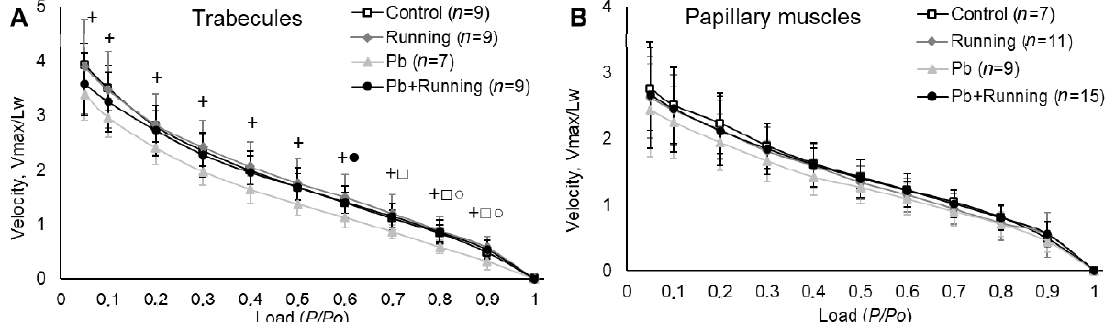
Figure 7. The force–velocity relationships of trabecules ( A ) and papillary muscles ( B ) in the experimental groups. Velocity is shown in relative units according to a muscle’s working length. The number of preparations is given in brackets. Data are presented as mean ± S.D. There are significant